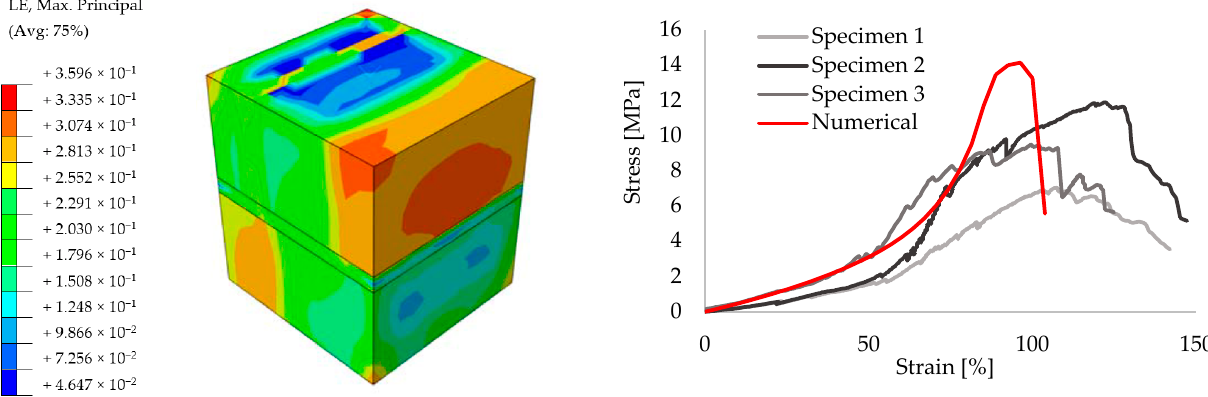
Figure 11. Compression results for the small size specimens with PolyUrethane PM: true strain diagram ( left ) and comparison of the numerical and experimental tests ( right ).